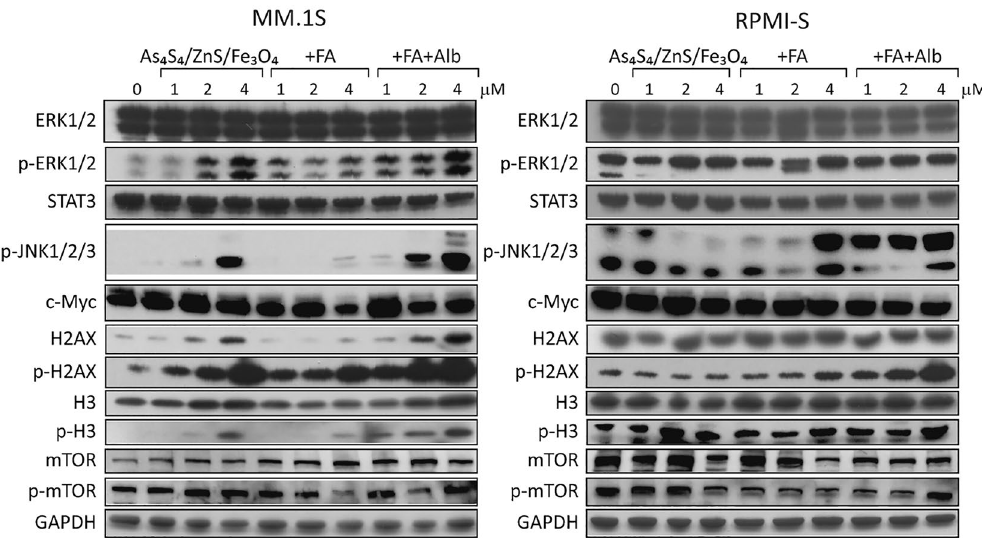
Figure 4. As 4 S 4 /ZnS/Fe 3 O 4 (1:4:1), As 4 S 4 /ZnS/Fe 3 O 4 (1:4:1) with FA, and As 4 S 4 /ZnS/Fe 3 O 4 (1:4:1) with FA and Alb induce activation in several signaling pathways and modulate expression of key regulatory molecules. MM.1S and RPMI-S cells were cultured with all 3NPs at 1, 2, and 4 µM for 8 h. Protein concentrations of whole cell lysates were measured using a Bradford protein assay kit. Western blot analysis from whole cell lysates (20 μg of proteins/lane) were immunoblotted using anti-ERK1/2, -p-ERK1/2, -STAT3, -p-JNK1/2/3, -c-Myc, -H2AX, -p-H2AX, -H3, -p-H3, -mTOR, and -p-mTOR antibodies. GAPDH served as a loading control. Results are representative of two independent